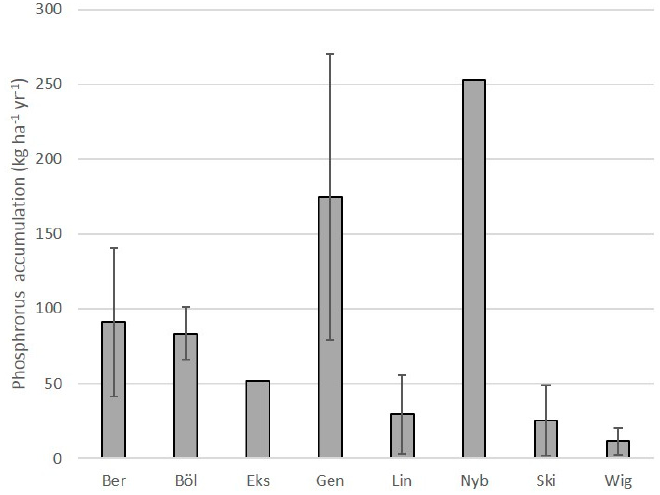
Figure 3. Phosphorus accumulation (kg per hectare wetland area and year) in eight created wetlands in agricultural areas in southern Sweden, based on measurements on sedimentation plates. Average values and standard deviations are shown for the six wetlands with two years of